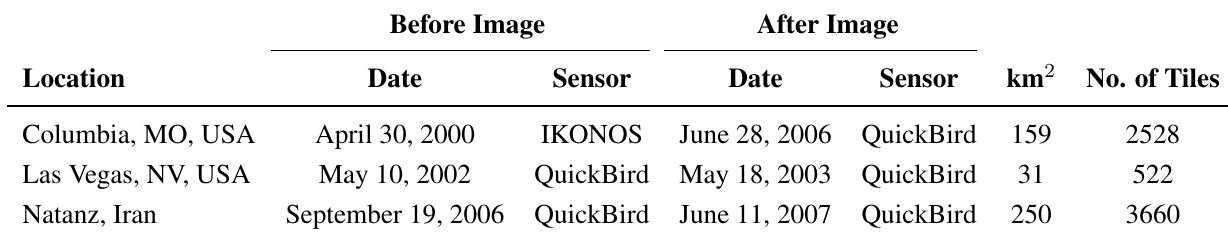
Before Image After